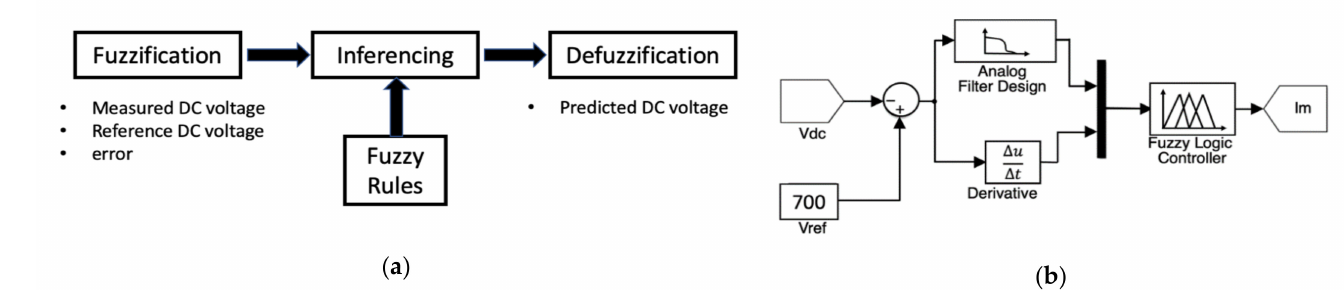
Figure 7. ( a ) Synoptic fuzzy inference architecture; ( b ) DC capacitor voltage control block.